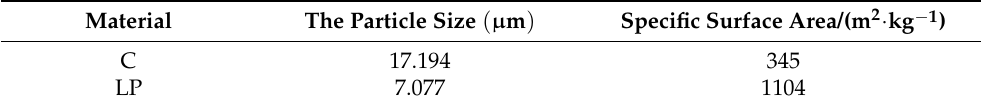
Table 4. Medium particle size and specific surface area of cement and limestone powder.